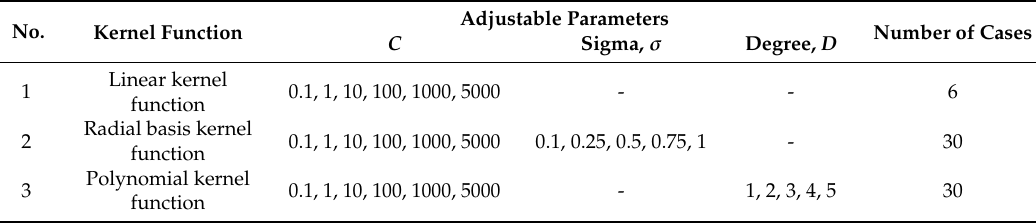
Table 7. Ranges of regularization factor ( C ), sigma ( σ ) and degree ( D ) used in support vector machine (SVM) model sensitivity